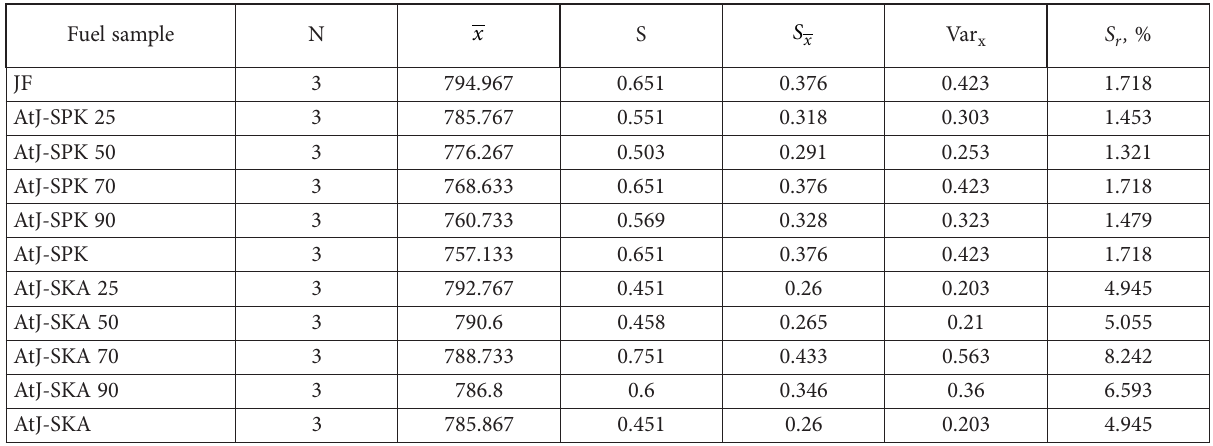
Table A1. Statistical error analysis of density measurements (source: author development) Fuel sample